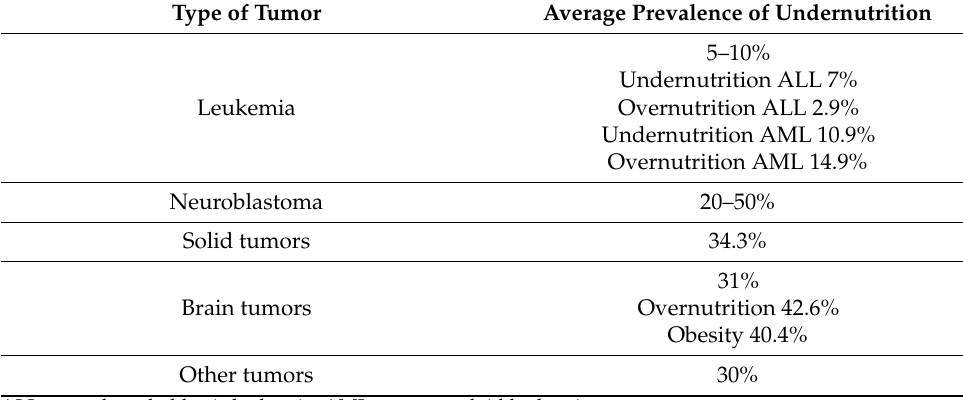
Table 5. Prevalence of undernutrition in different cancer